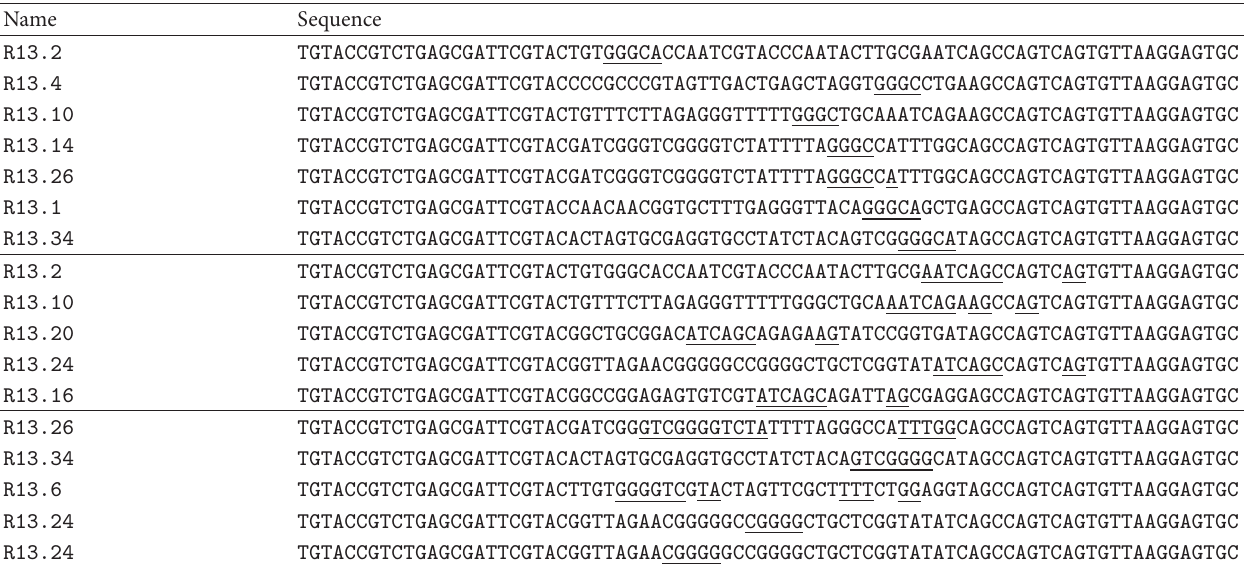
Table 2: R13 sequence families.